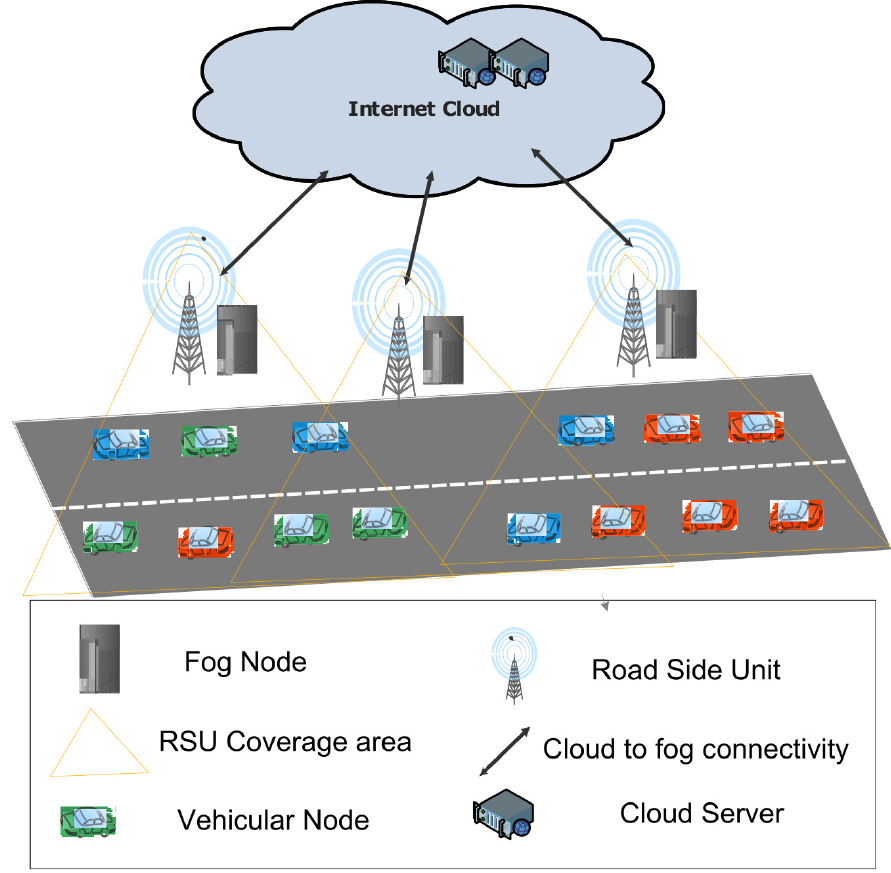
Figure 1. System